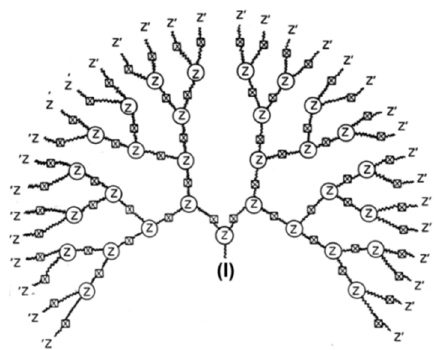
Figure 4. Two-dimensional projection of a monodendron with symmetrical branch junctures (i.e., Tomalia topologies) and Z = branch cell junctures with equal branch segments. Reprinted with permission from [28]. Copyright 1987 American Chemical Society.